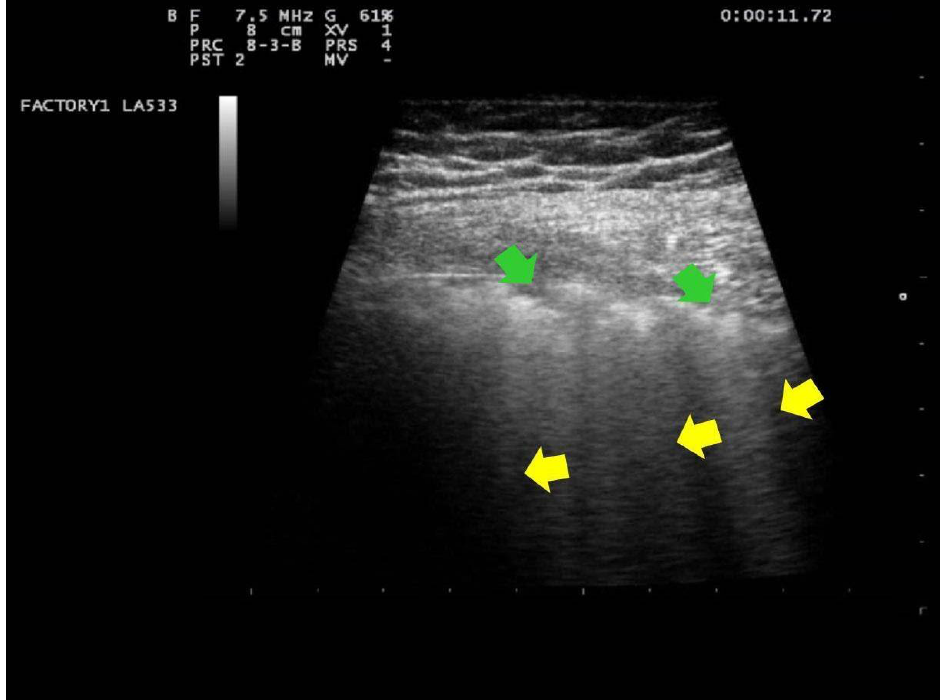
Figure 3. Lung US images obtained with linear transducers, frequency 7.5 MHz, focus on the pleural line. Trapezoidal view. The pleural line is not continuous. Below the point of discontinuity (indicated by green arrows), vertical areas of white (or B lines) are visible (indicated by yellow arrows). B-lines occupying >50% the screen. This pattern is classified as score 2.